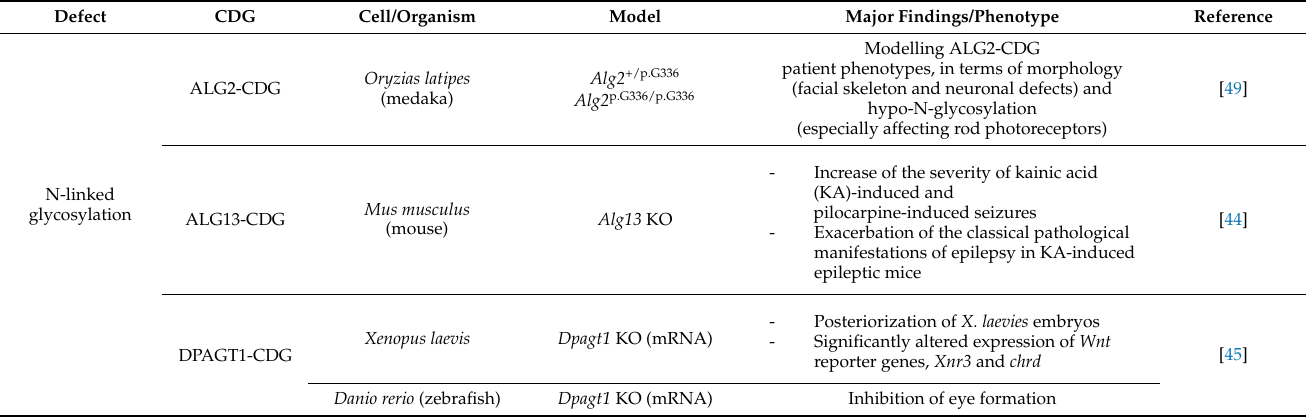
Table 2. Overview of in vitro and in vivo disease models for congenital disorders of glycosylation (CDG) reported since October 2017 to March 2022. NR: not reported; MO: morpholino oligonucleotide; KO: knockout; KD: